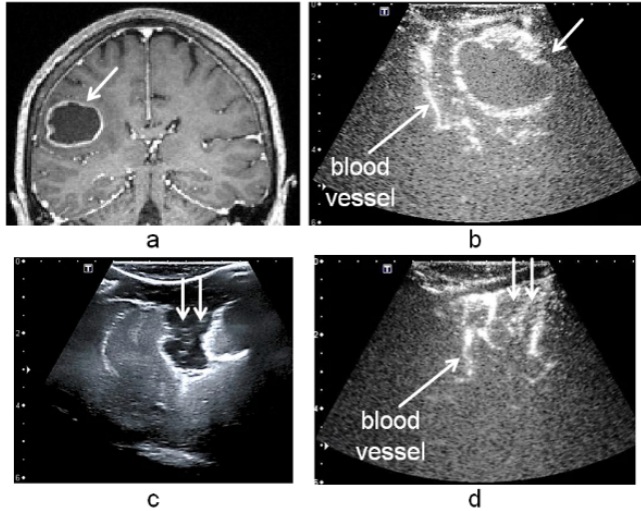
Figure 1. Patient image data acquired during tumor resection. The brain tumor (white arrow) is represented in the preoperative cT1MR data ( a ) and in the 3D-iCEUS start ( b ) acquired at the beginning of the operation. After tumor removing, the resection cavity (indicated by two white arrows in ( c ) and ( d ) is well visible in the B-mode ultrasound image ( c ). In the 3D-iCEUS end acquired at the end of the operation ( d ); the borders of the cavity can be easily interpreted as a blood